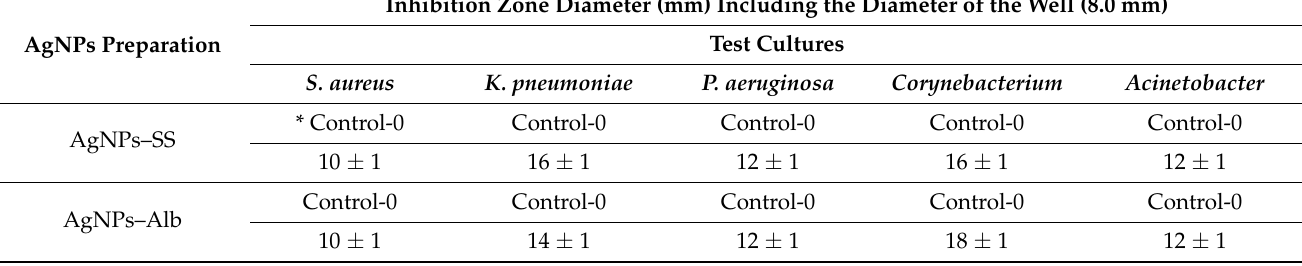
Table 4. Size of the growth inhibition zones after treatment of the different microbial cultures with the AgNP preparations. AgNPs Preparation